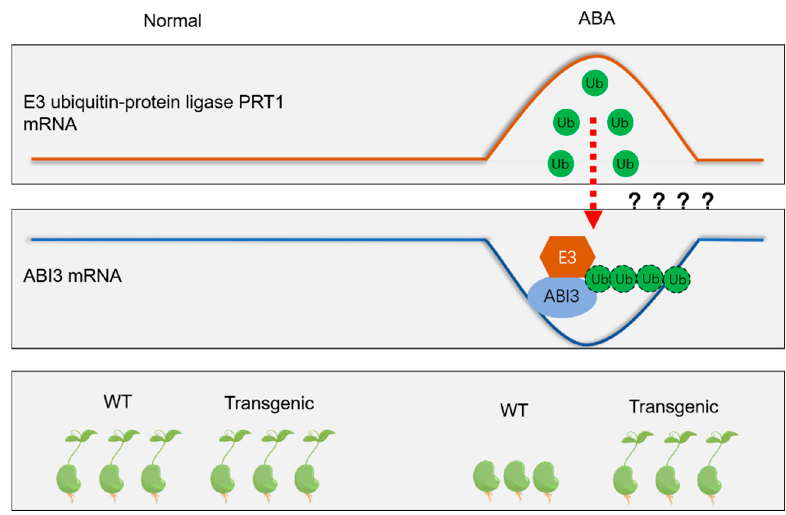
Figure 7. A possible model for the interaction between ScABI3 and ScPRT1 in response to ABA treatment is proposed.